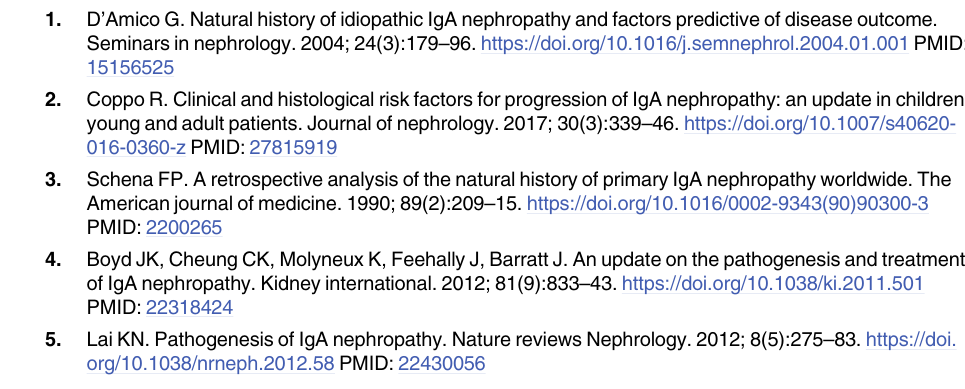
S6 Fig. Levels of CD14, MIP-1 and fractalkine in plasma from IgA nephropathy patients and healthy controls. S7 Fig. The relationship between IL-6 and non-classical monocytes in IgAN patients using linear regression